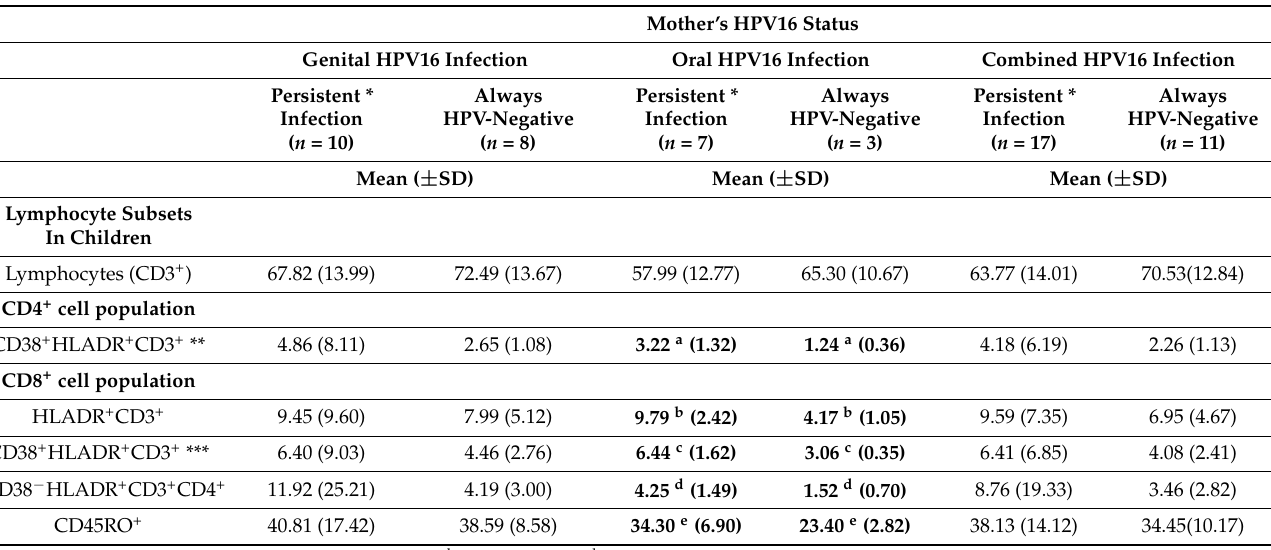
Table 6. Proportion of CD4 + or CD8 + lymphocytes by their immunophenotypic subsets * given as mean ( ± SD) percentages among children whose mothers had persistent genital or oral HPV16 infec- tion or were always HPV-negative. Only the lymphocyte subsets that had a statistically significant difference between the groups are given, results are